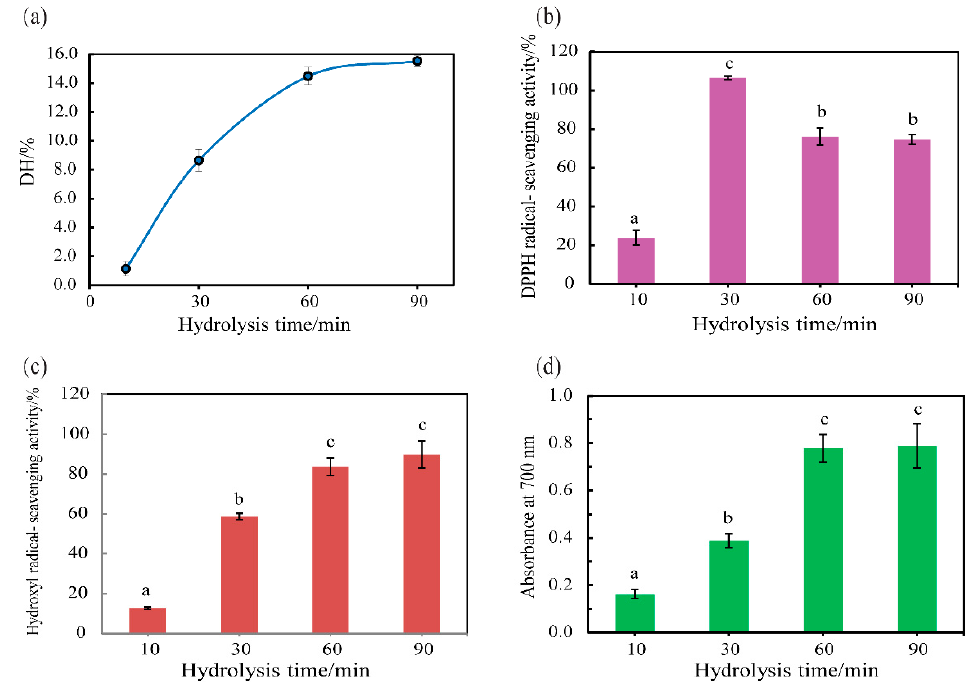
Figure 6. Antioxidant activity of half-fin anchovy hydrolysates digested with SVCE3(f) at different times. ( a ) Degree of hydrolysis, ( b ) DPPH scavenging activity, ( c ) hydroxyl radical scavenging activity, and ( d ) ferric reducing power. Data were presented as mean ± SD ( n = 3). Different letters represent significant differences ( p < 0.05).